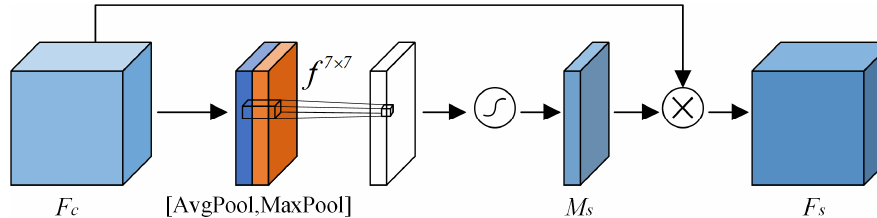
Figure 7. Spatial attention Figure 7. Spatial a tt ention mechanism.